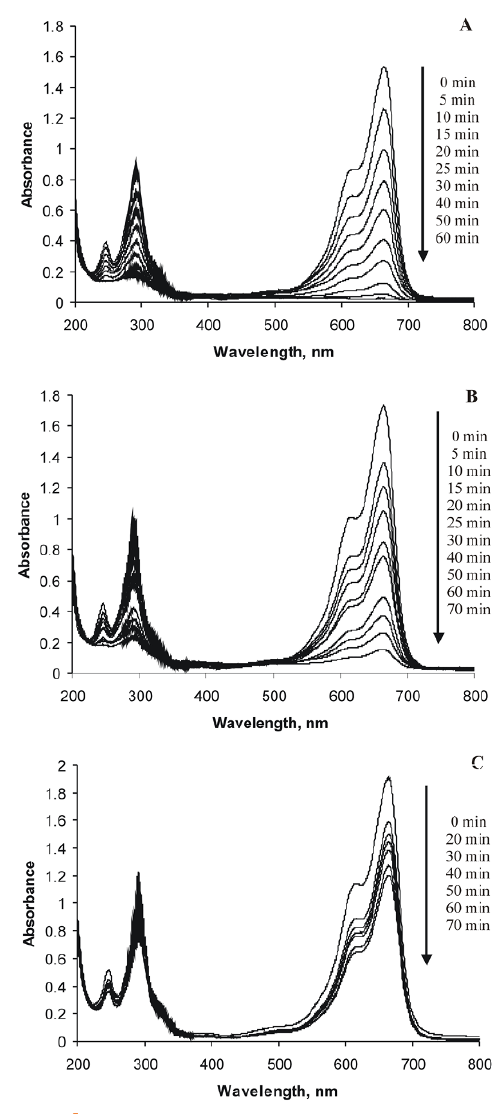
Figure 4. UV-Vis spectral changes for MB degradation by using different catalysts (A) Co-fresh; (B) Co-Fe-fresh; (C)